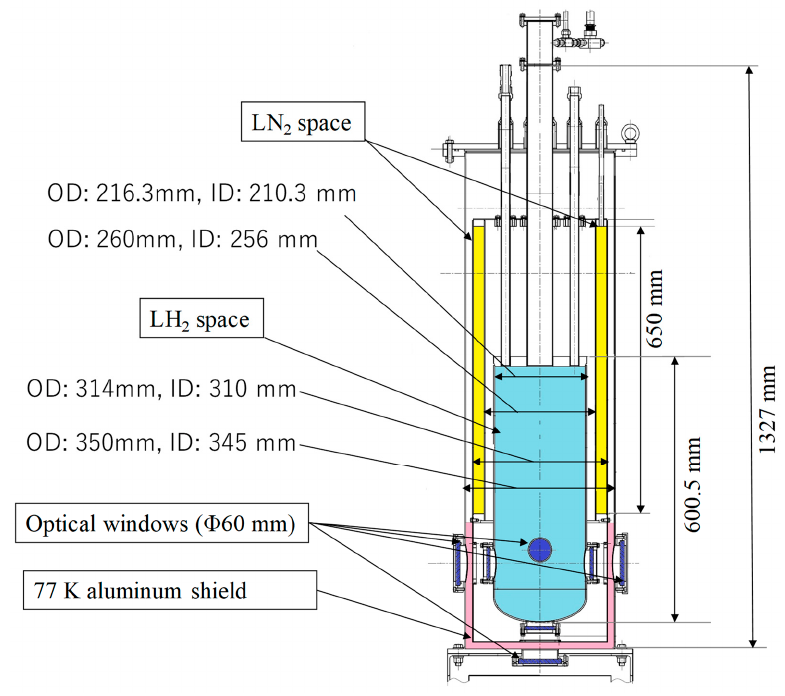
Figure 2. Schematic diagram of the experimental apparatus.